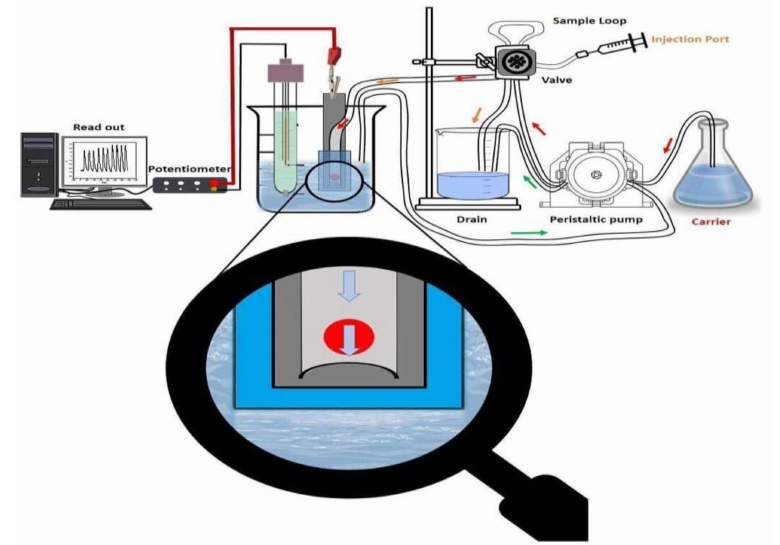
Figure 4. Flow injection manifold for ACh + quantification. Conditions: phosphate-bu ff ered saline (PBS) (0.01 M, pH 7.0) carrier solution; 100 µ L was the injected sample volume with a 4.0 mL / min flow